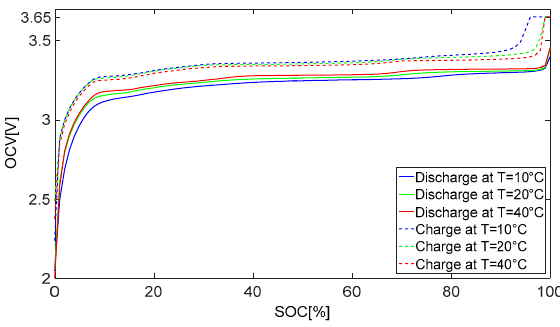
Figure 5. Charge and discharge OCV curves over SOC.